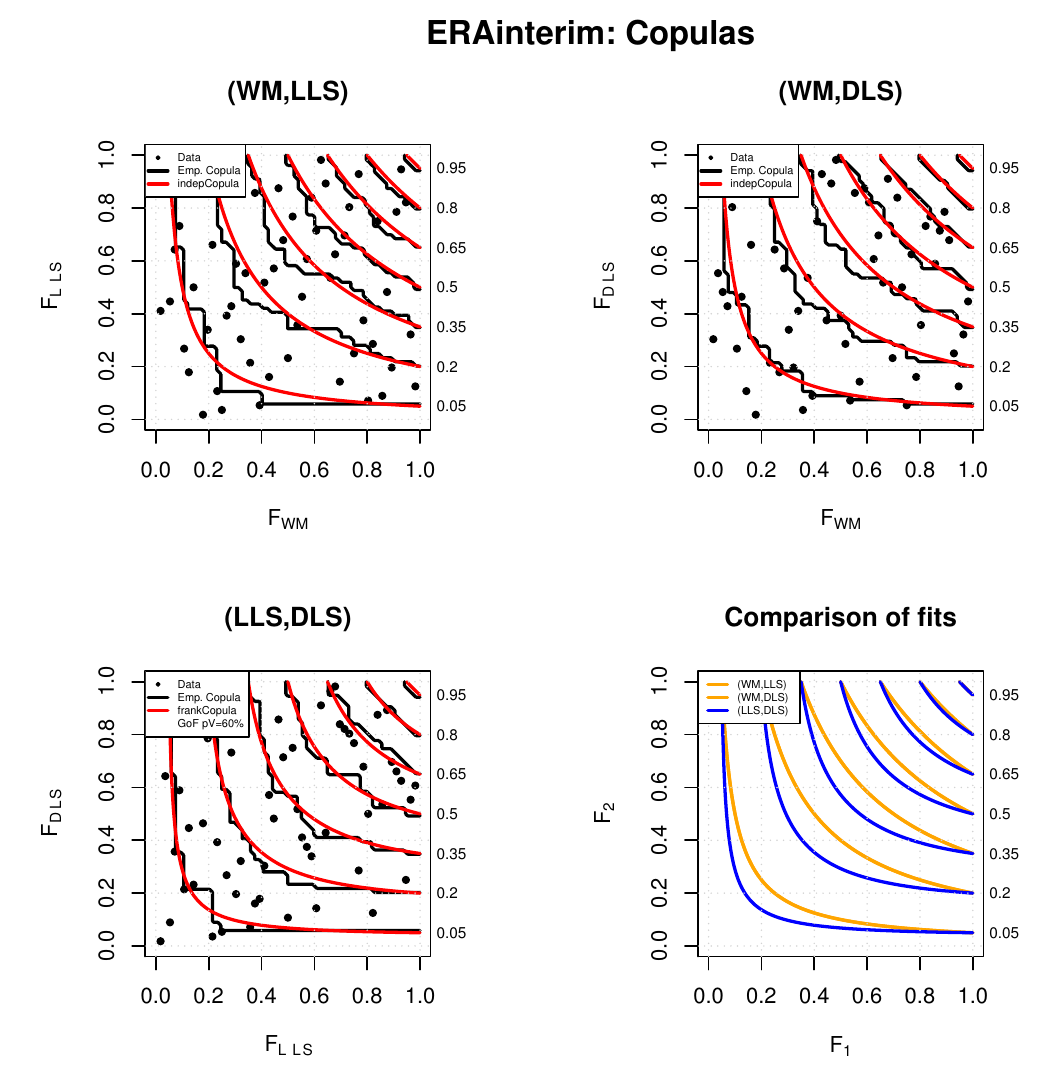
Figure A5. Same as Figure 6 but considering the ERA-Interim